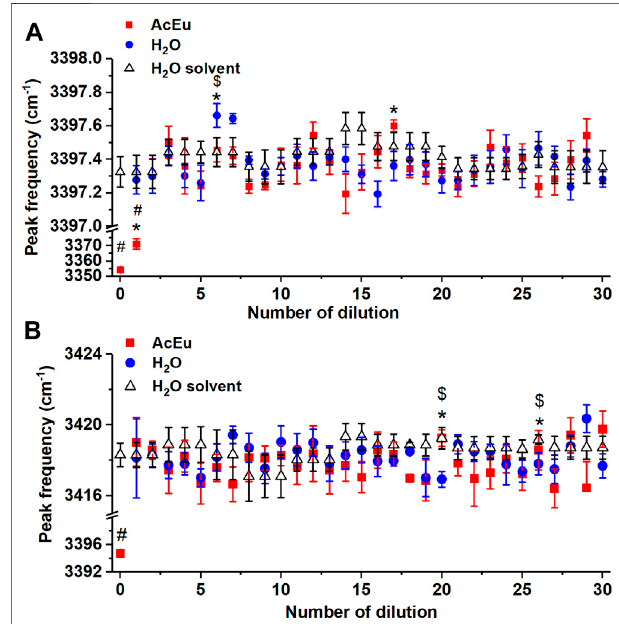
FIGURE 4 | Dependence of the position of the maxima of Raman bands 3240 cm − 1 (A) and3420 cm − 1 (B) onthenumberofdilutionsoftheinitialAcEusolution and water. Daily water monitoring is also shown. * — statistically signi fi cant difference between AcEu dilution and the respective water dilution, # — statistically signi fi cant difference between AcEu dilution and water, $ — statistically signi fi cant difference between water dilution and water. The data are presented as mean ±